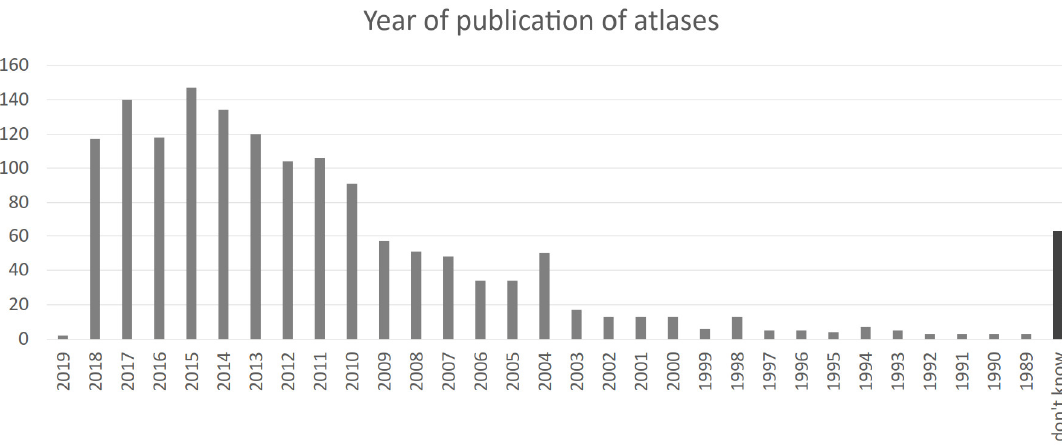
Figure 5. Year of publication of the atlases used in Czech schools.